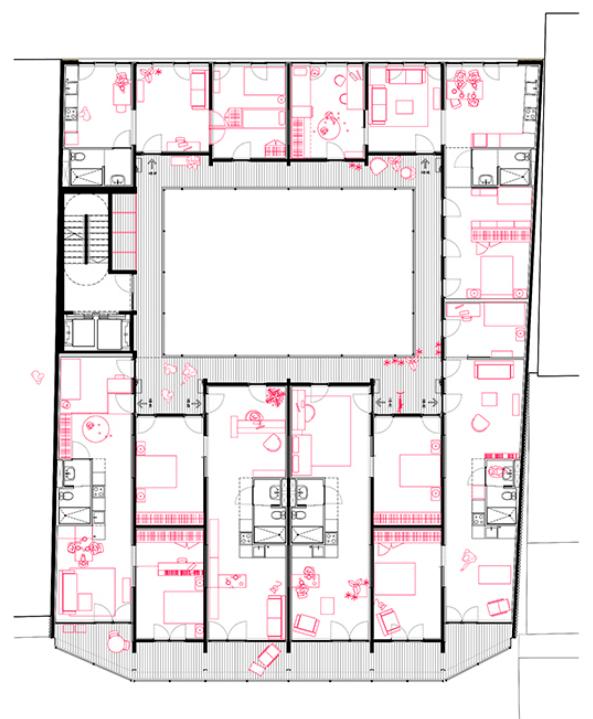
Figure 3. La Borda Cooperative Housing, 4th floor. EU Mies Award Archive. https://eum- iesaward.com/work/4554 (accessed on 8 February 2021). com/work/4554 (accessed on 8 February